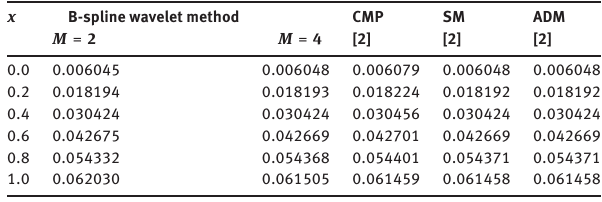
Table 1: Comparison of numerical results obtained by B-spline wavelet method with the results of other available methods in ref. [2] (for λ = 10 , β = 3 and μ = 0.02 ) x B-splinewaveletmetho d CMP SM ADM M = 2 M = 4 [2] [2] 0.0 0.006045 0.006048 0.006079 0.006048 0.006048 0.2